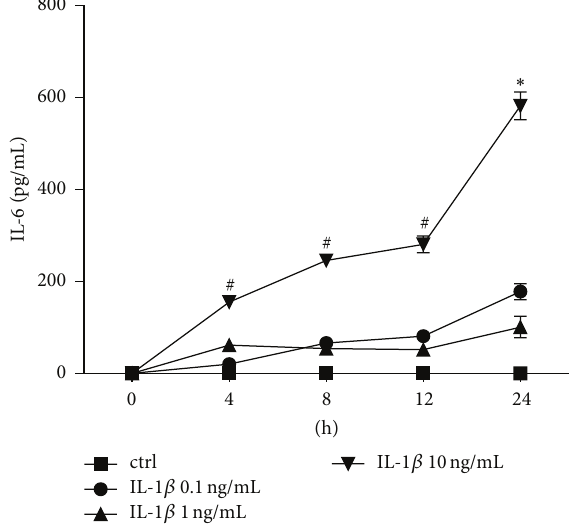
Figure 3: Interleukin (IL)-6 release from lung epithelial cells A549 after IL-1beta stimulation. Cells were stimulated with IL- 1beta in indicated concentrations for different intervals (incubation time indicated below the 𝑥 -axis). After the incubation periods, supernatants were analyzed for IL-6 concentrations. The data are presented as means ± s.e.m. ∗ 𝑃 < 0.05 , all groups versus corresponding control (ctrl); # 𝑃 < 0.05 , IL-1beta 10ng/mL versus corresponding ctrl.